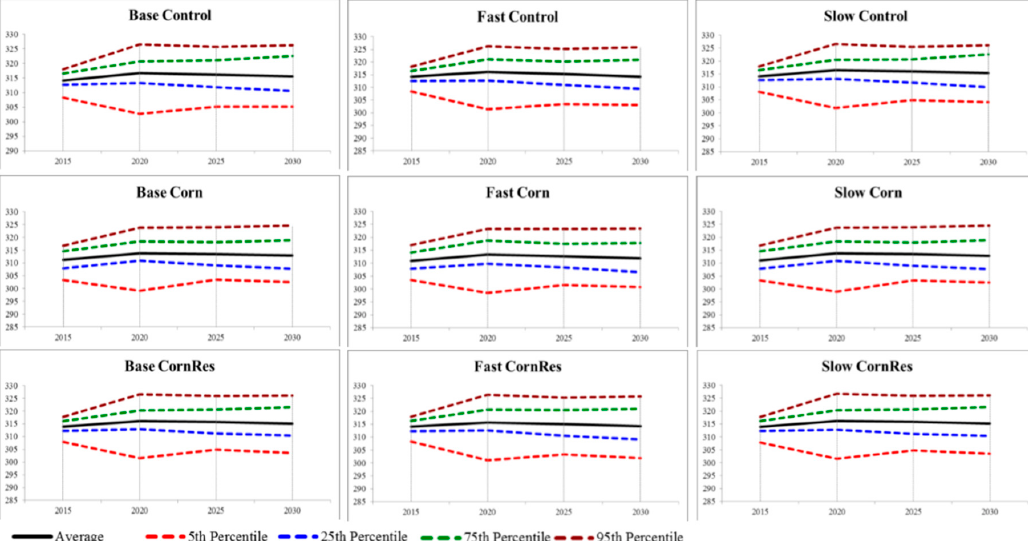
Figure A3. Variability of U.S. cropland pasture used for livestock (in million acres) stochastic draw during 2015 to 2030 under various biofuel policy and demand growth scenarios. References 1.